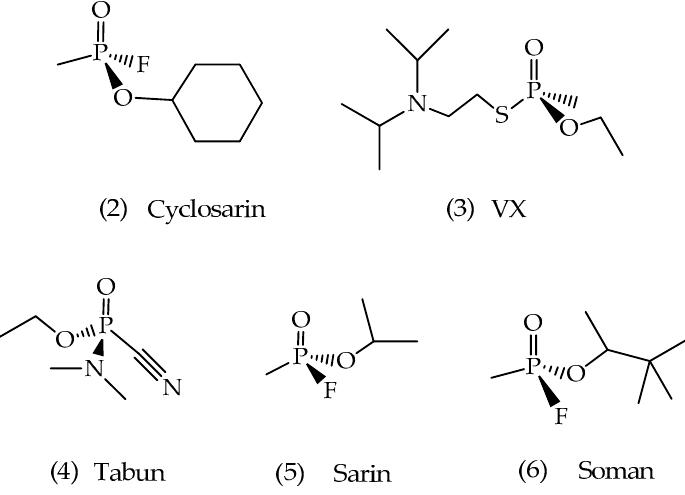
Figure 5. Chemical structures of the main warfare nerve agents.